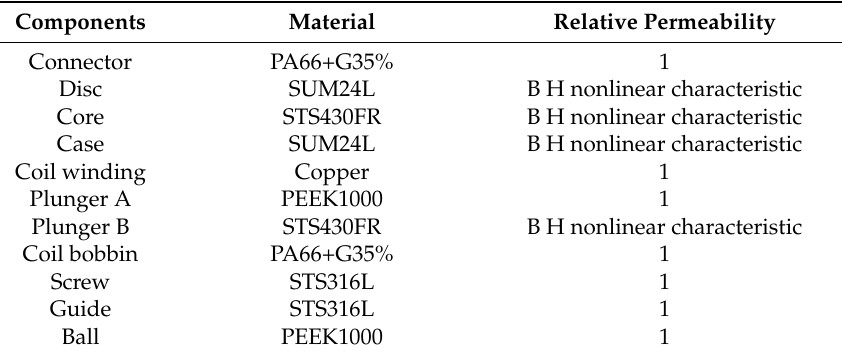
Table 4. Magnetic properties of components.